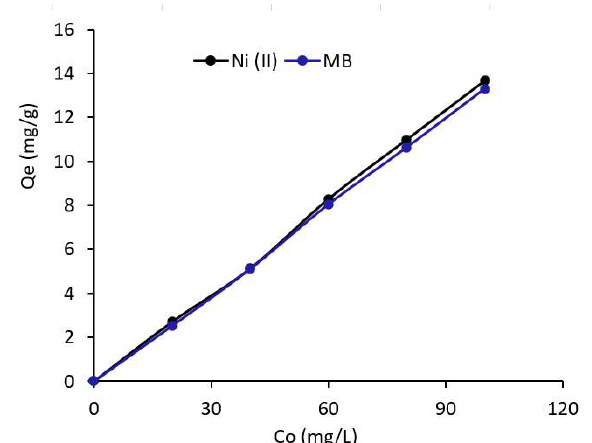
Fig.5. The effect of initial pH of solution on the removal efficiency of Ni(II) and MB from solution by natural clay